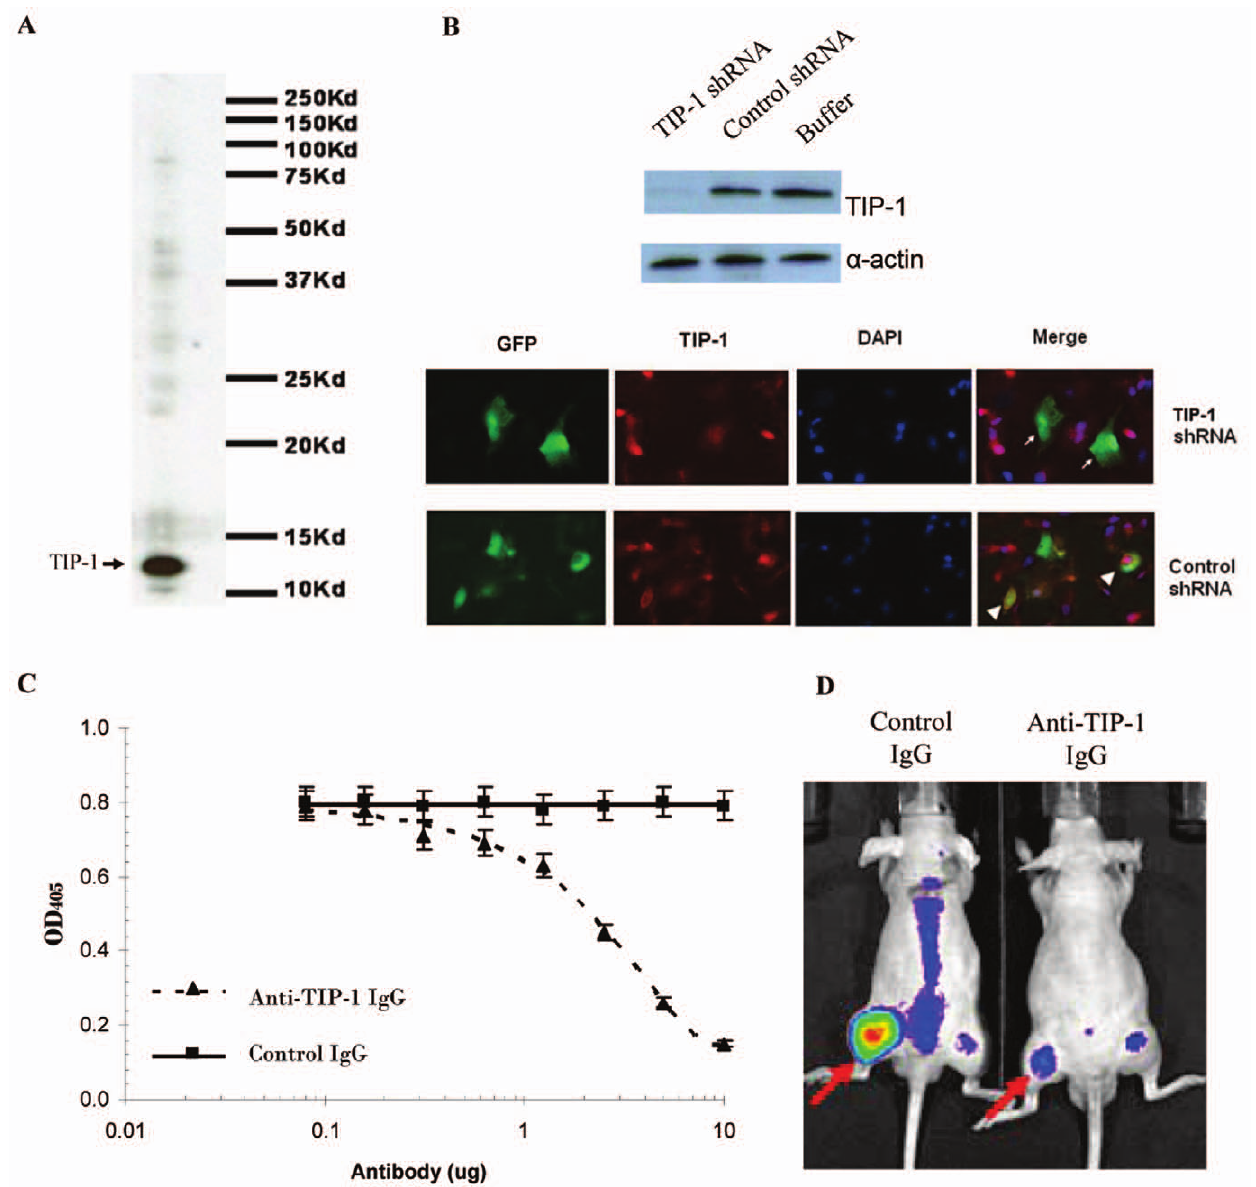
Figure 2. TIP-1 specific antibody blocked the HVGGSSV peptide binding within irradiated tumor. A : Specificity of the TIP-1 antibody as revealed with western blot analysis of whole LLC cell lysate. The endogenous TIP-1 protein ( , 14 kD) recognized by the antibody was pointed with arrow. B : Specificity of the TIP-1 antibody as demonstrated in immunofluorescent staining of LLC cells that were transfected with shRNA plasmids. Effect of the TIP-1 targeting shRNA on TIP-1 expression was determined with western blot analysis (upper panel). In the cell staining, the transfected cells were tracked with GFP protein expression from the shRNA plasmids. TIP-1 was stained as red with the TIP-1 antibody. Cell nuclei were stained with DAPI. The LLC cells transfected with the control shRNA that did not affect TIP-1 expression were pointed with arrow head, while the cells transfected with TIP-1 targeting shRNA that abolished TIP-1 expression were pointed with arrows (lower panel). C : ELISA-based in vitro competition assay. Serially diluted antibodies were respectively pre-incubated with the purified GST/TIP-1 proteins (100 ng/well) before the complex was added to the plates coated with the HVGGSSV peptide (50 ng/well). The GST/TIP-1 protein associated to the immobilized HVGGSSV peptide was detected with GST-specific antibody. D : Optical images of LLC tumor-bearing mice that were co-administrated with the Alexa Fluor 750-labeled HVGGSSV peptide and antibodies. LLC tumors in the left hind limbs were irradiated at 5 Gy (pointed with arrows). 200 m g of the TIP-1 antibody, or the control antibody, was injected at 2 hours post the IR treatment, followed by injection of Alexa Fluor 750-labeled HVGGSSV peptide at 4 hours post the IR treatment. Optical images were acquired 24 hours after the peptide injection. The presented data represent three independent experiments.